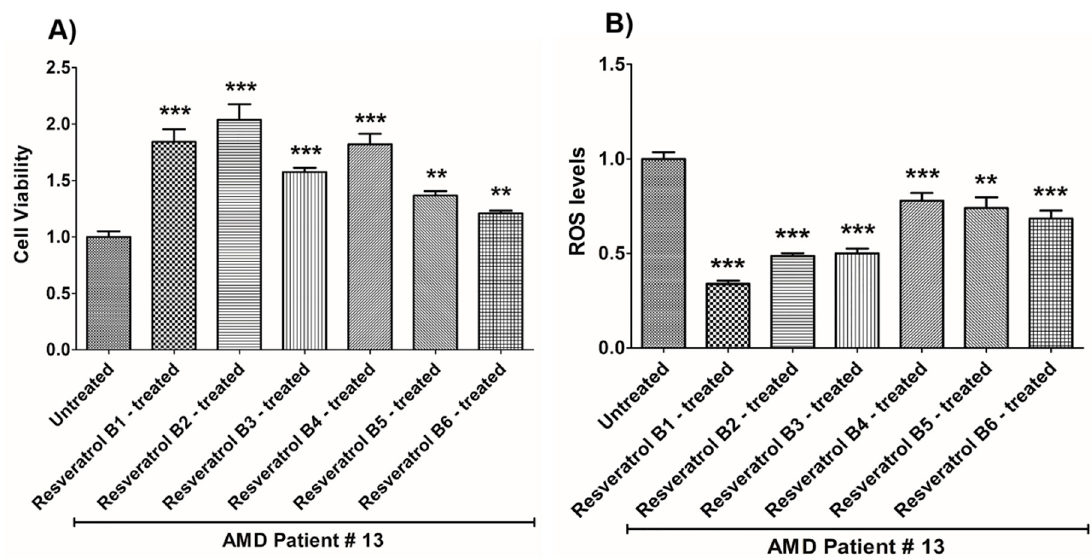
Figure 13. Effects of resveratrol formulations on cell viability ( A ) and ROS levels ( B ) in AMD patient